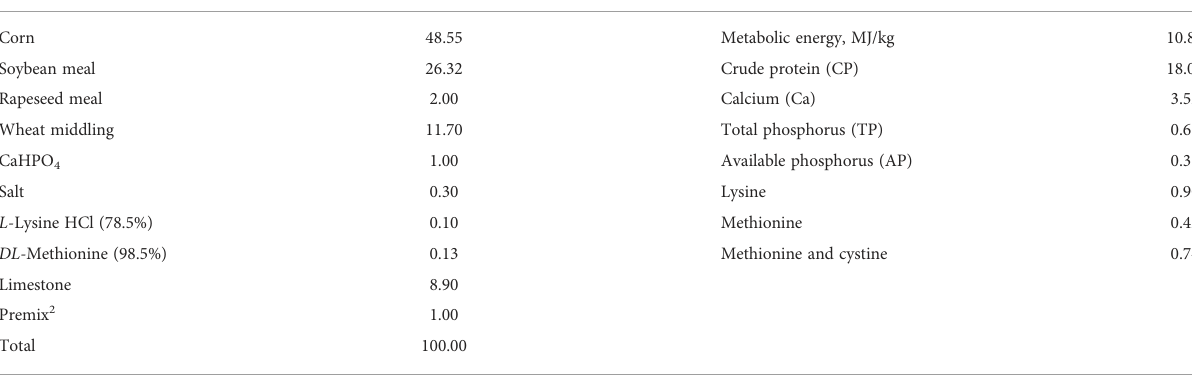
TABLE 1 Ingredients and nutrient composition of the basal diet (dry matter basis,